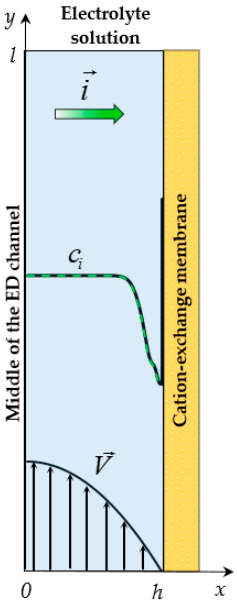
Figure 1. Scheme of the system under consideration: half of the desalination electrodialysis (ED) cell adjacent to the cation-exchange membrane (CEM). Schematic concentration profiles of cations ( c 1 , solid line) and anions ( c 2 , dashed line), direction of the electric current i are shown.